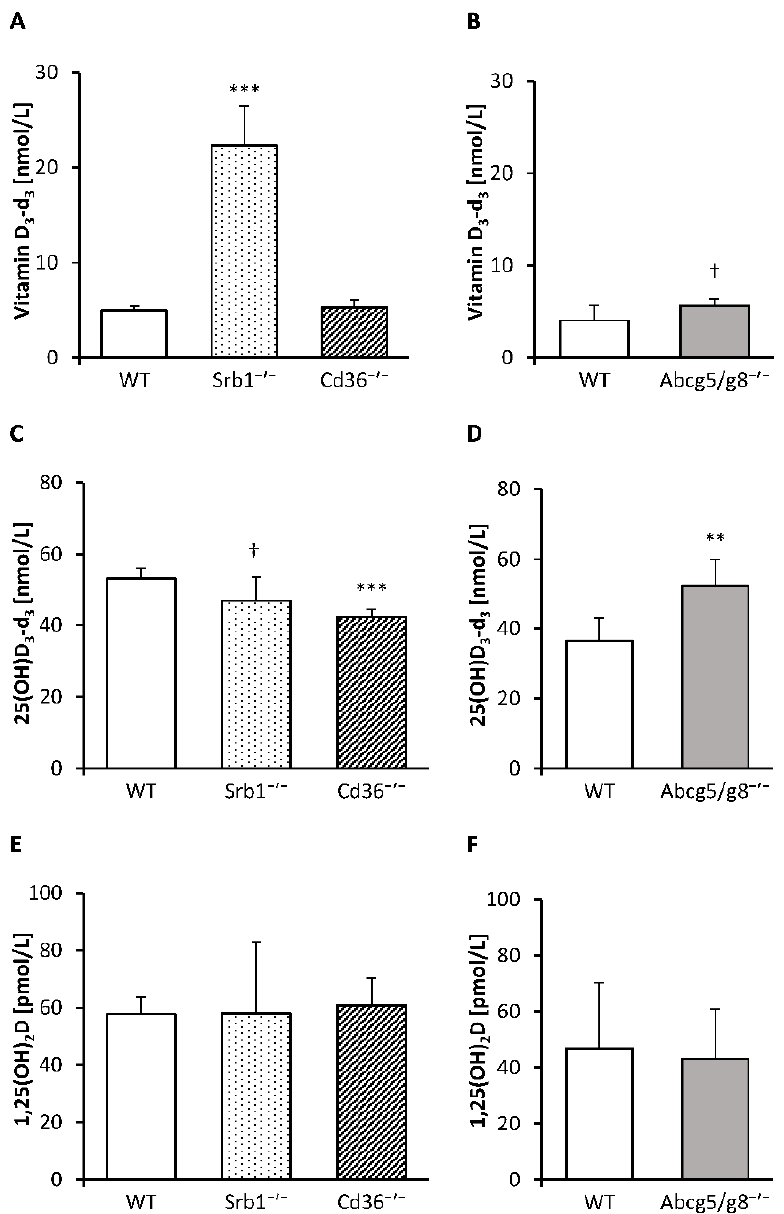
Figure 1. Serum concentrations of vitamin D 3 -d 3 in Srb1 - / - and Cd36 - / - mice versus corresponding wild-type (WT) mice ( A ) and Abcg5 / g8 - / - mice versus corresponding WT mice ( B ). Serum concentrations of 25(OH)D 3 -d 3 in Srb1 - / - and Cd36 - / - mice versus corresponding WT mice ( C ) and Abcg5 / g8 - / - mice versus corresponding WT mice ( D ). Serum concentrations of 1,25(OH) 2 D in Srb1 - / - and Cd36 - / - mice versus corresponding WT mice ( E ) and Abcg5 / g8 - / - mice versus corresponding WT mice ( F ). All mice were fed diets containing 25 µ g / kg triple-deuterated vitamin D 3 (vitamin D 3 -d 3 ) for six weeks. Data are presented as the means ± SD, n = 5–7; *** p < 0.001, ** p < 0.01, † p < 0.1 (compared to the corresponding WT mice, Student’s t test). 1,25(OH) 2 D, 1 α ,25-dihydroxyvitamin D; 25(OH)D 3 -d 3 , triple-deuterated 25-hydroxyvitamin D 3 ; Abcg5 / g8 - / - , ATP-binding cassette transporters G5 / G8 knockout mice; Cd36 - / - , cluster determinant 36 knockout mice; Srb1 - / - , scavenger receptor class B type 1 knockout